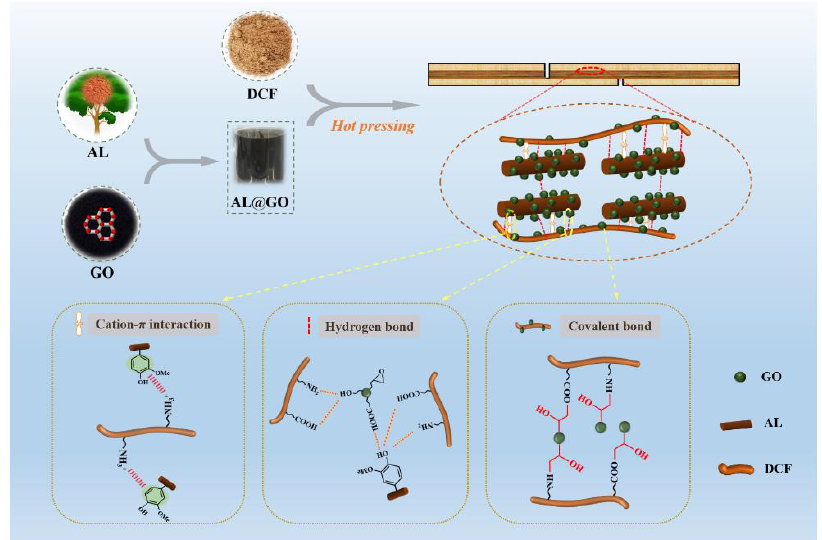
Figure 1. Schematic of the interaction of cottonseed-lignin adhesive components in woody composite materials.